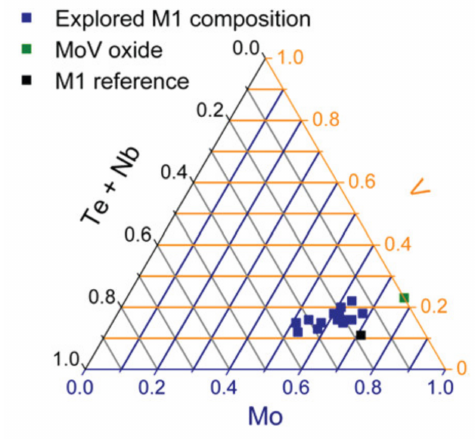
Figure 6. Metal stoichiometry (at. %) of M1 catalysts prepared by different methods. The Te- and Nb-free MoV oxide with orthorhombic structure was prepared for reference. Adapted from ref. [72], Copyright (2010), with permission from the American Chemical